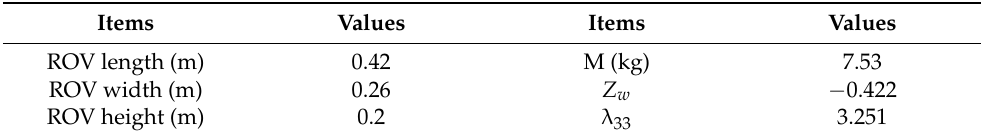
Table 2. ROV parameters.